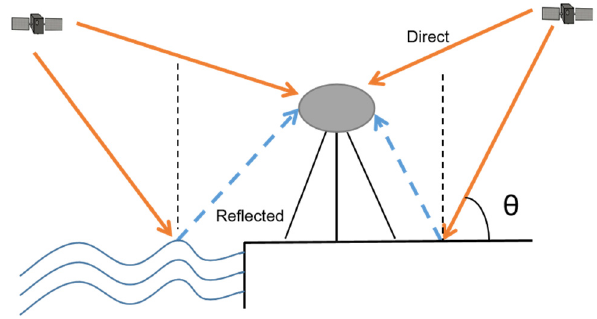
Figure 1. Schematic diagram of GNSS reflected signal.